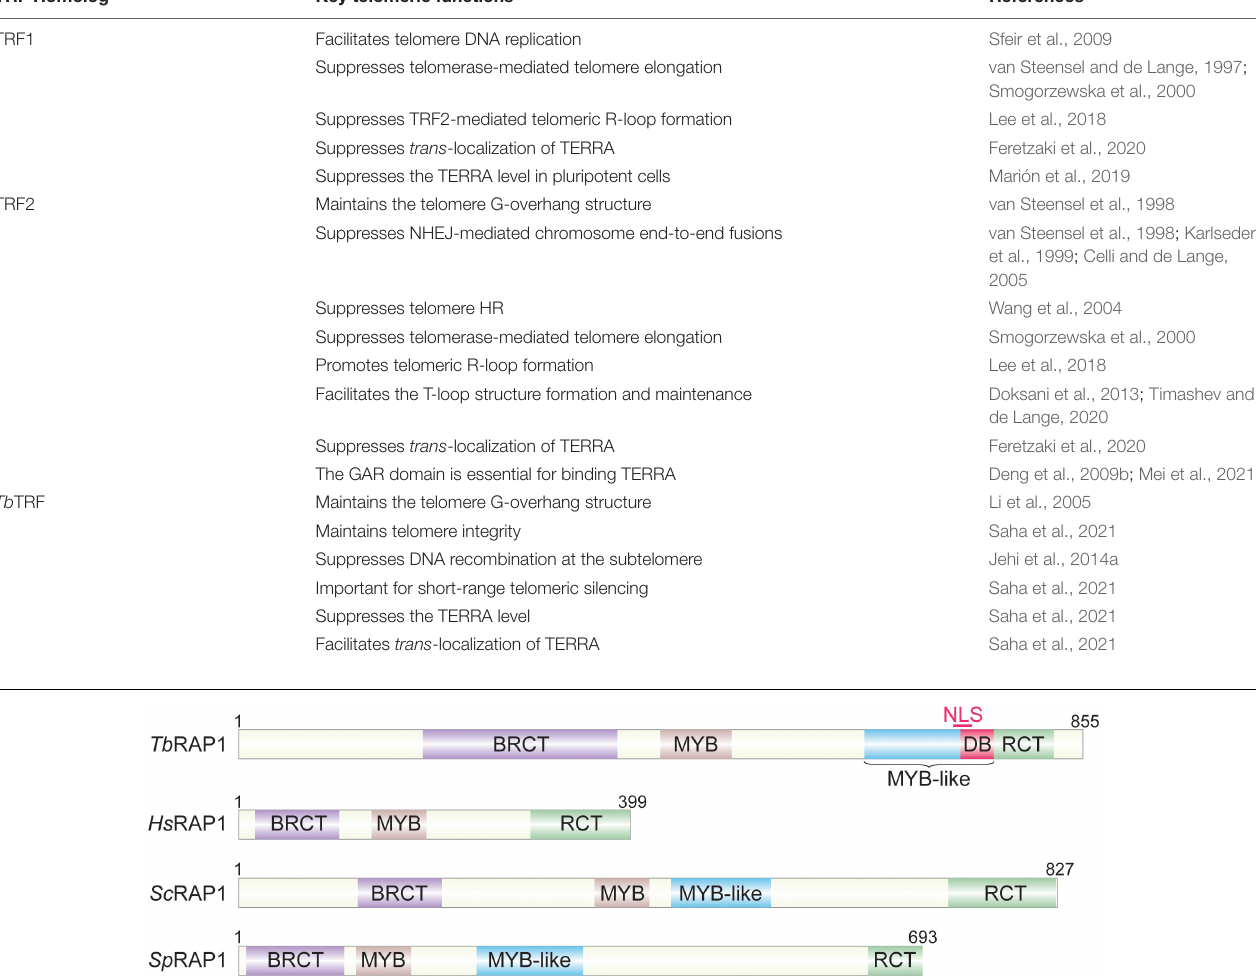
FIGURE 3 | Repressor activator protein 1 (RAP1) homologous. Tb , Trypanosoma brucei ; Hs , Homo sapiens ; Sc , Saccharomyces cerevisiae ; Sp , Schizosaccharomyces pombe